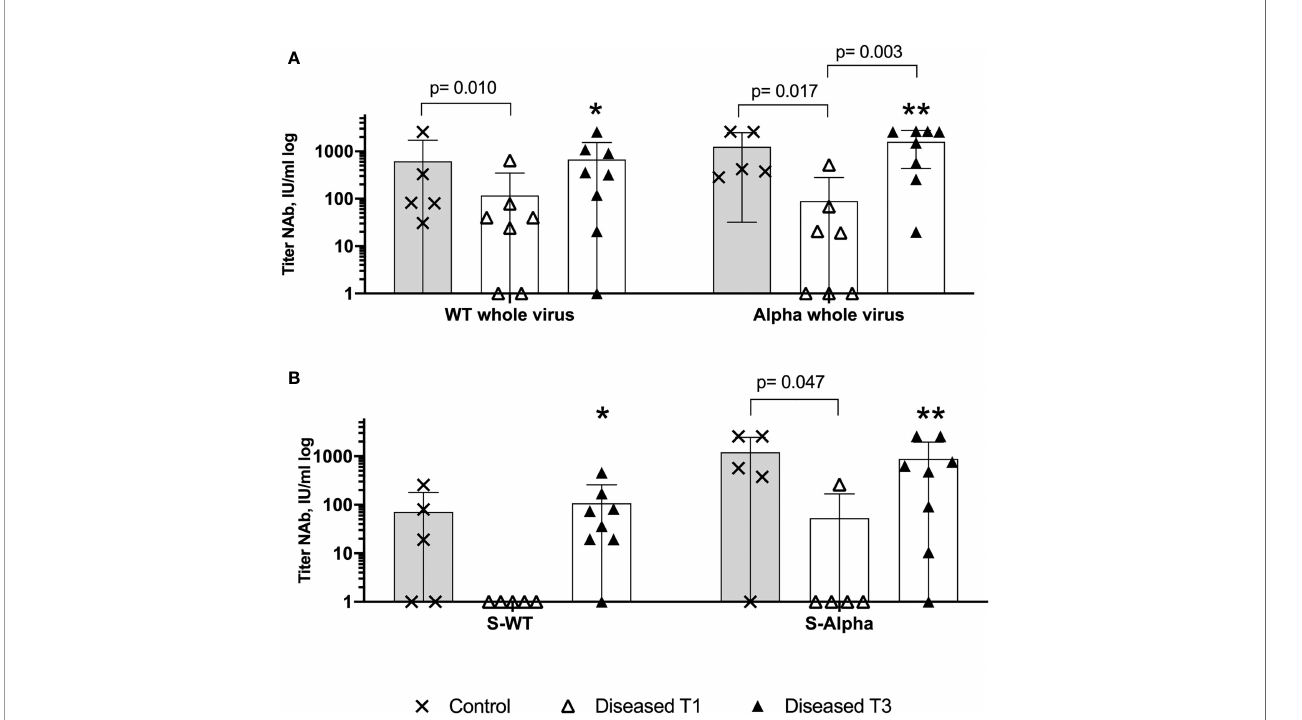
FIGURE 3 | Insuf fi cient WT and Alpha neutralizing antibodies production on disease onset. Anti-Sars-CoV-2 S protein and whole virus binding neutralizing antibodies assessed with WT virus hCoV-19 and VOC B.1.1.7 (Alpha). Comparison of the relative titers of SARS-CoV-2 neutralizing antibodies with the 50% neutralization dose among VBI, at T1 and T3, and the control cohort. (A) There is a signi fi cantly higher neutralizing potential of the control cohort against the Alpha whole virus, WT whole virus and (B) against the S-Alpha at disease onset, indicating failure of the anti-SARS-CoV-2 vaccination to generate protective humoral immunity among the diseased cohort. ⁎ (WT whole virus VBI T3 versus S-WT VBI T3), ⁎⁎ (Alpha whole virus VBI T3 versus S-Alpha T3). Increased neutralizing antibodies titers at T3, with Alpha and WT whole virus NAb titers are statistically signi fi cantly higher compared to S-WT and S-Alpha NAb at T3, implying reduced immunogenicity of the diseased cohort against the SARS-CoV-2 Spike (WT NAb versus S-WT NAb p=0.015, Alpha NAb versus S-Alpha NAb p=0.015). Paired data was compared with Wilcoxon matched pairs test, whereas unpaired data with Mann-Whitney-test. P<0.05 was considered signi fi cant, only signi fi cant p values are documented in the fi